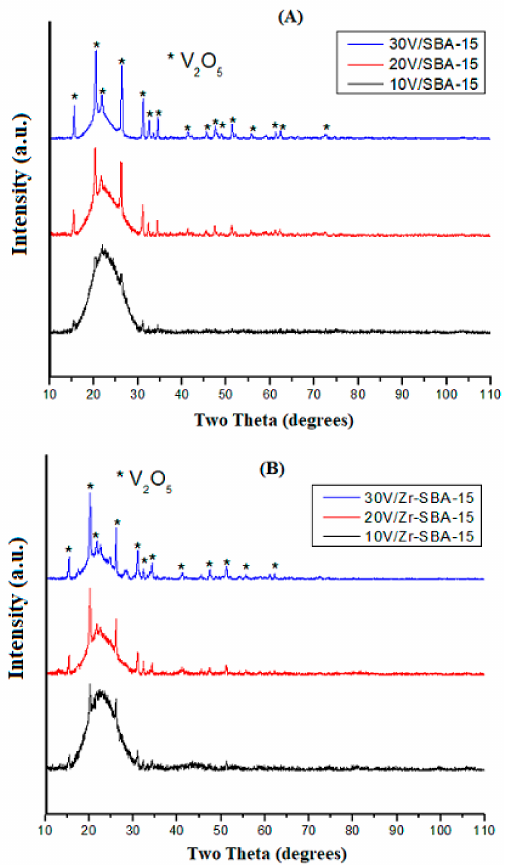
Figure 1. XRD spectra of catalysts ( A ) SBA-15 and V 2 O 5 /SBA-15; ( B ) Zr-SBA-15 and V 2 O 5 /Zr-SBA-